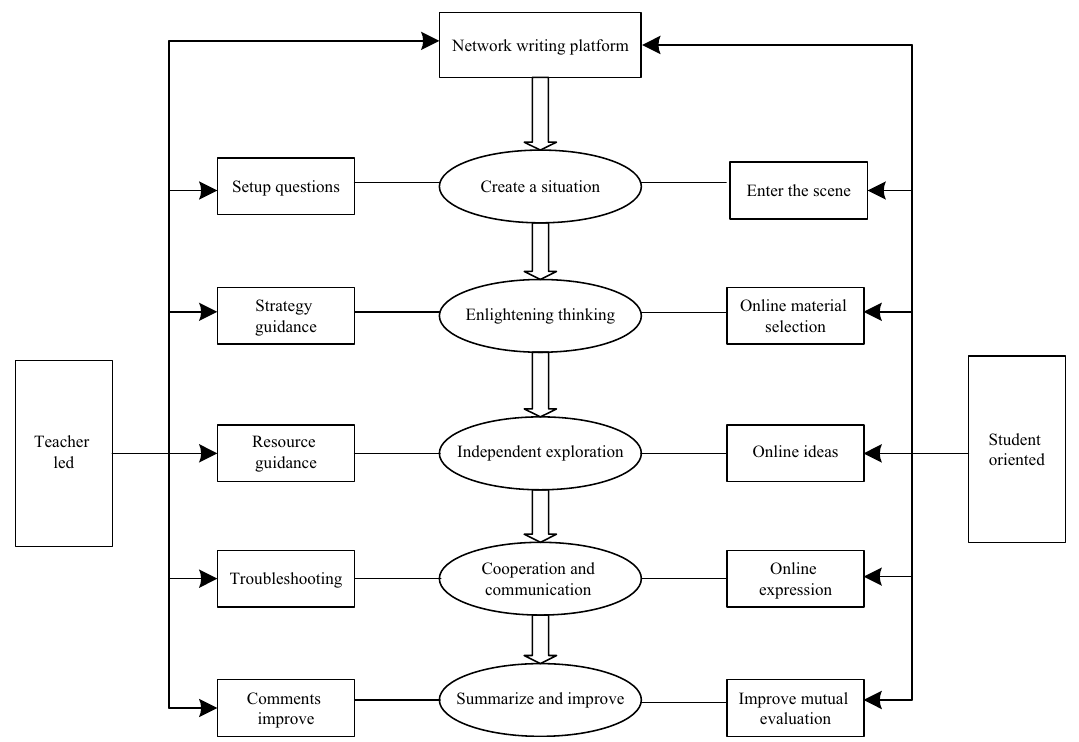
Figure 1: Teaching mode of English writing based on multiple dynamic